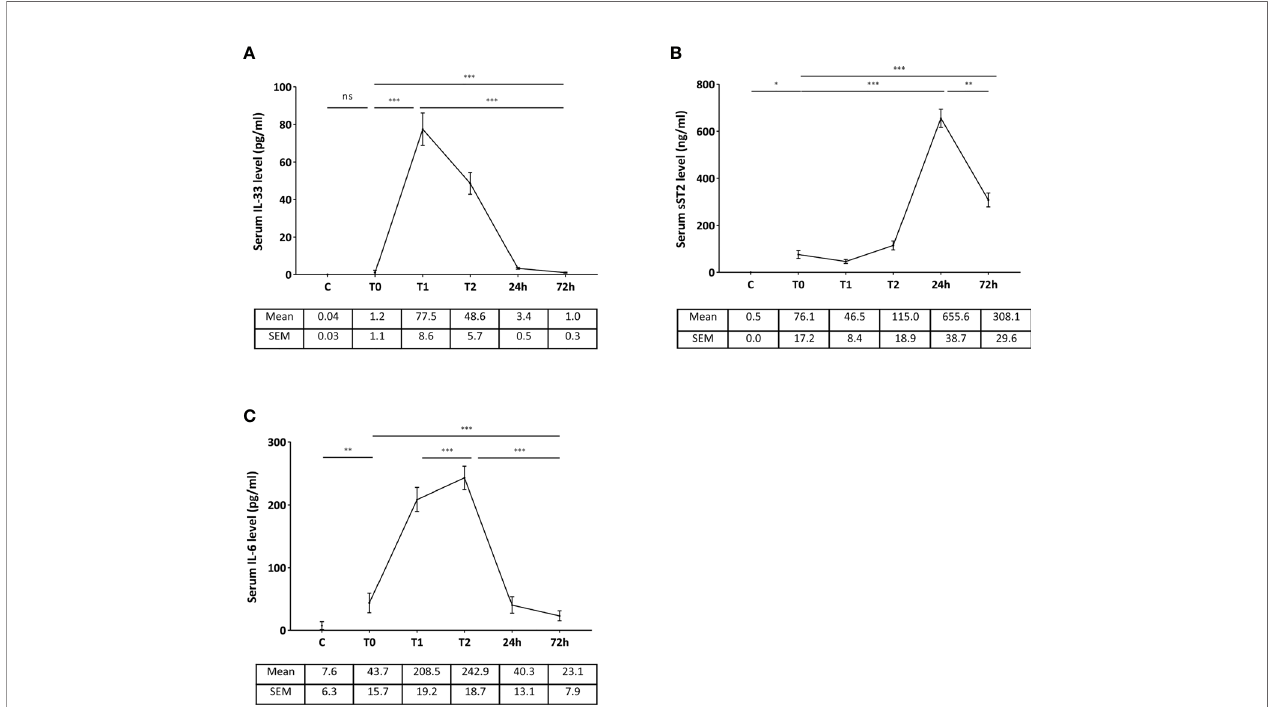
FIGURE 3 | Kinetics of serum levels of IL-33 (A) , sST2 (B) , and IL-6 (C) in the peritransplant period (LT patients). (C) T0: before LT, T1: immediately after reperfusion, T2: at the end of liver transplantation. Control subjects (C) were used for IL-33 ( n = 15), IL-6 ( n = 8), and sST2 ( n = 8). Data are expressed as means ±